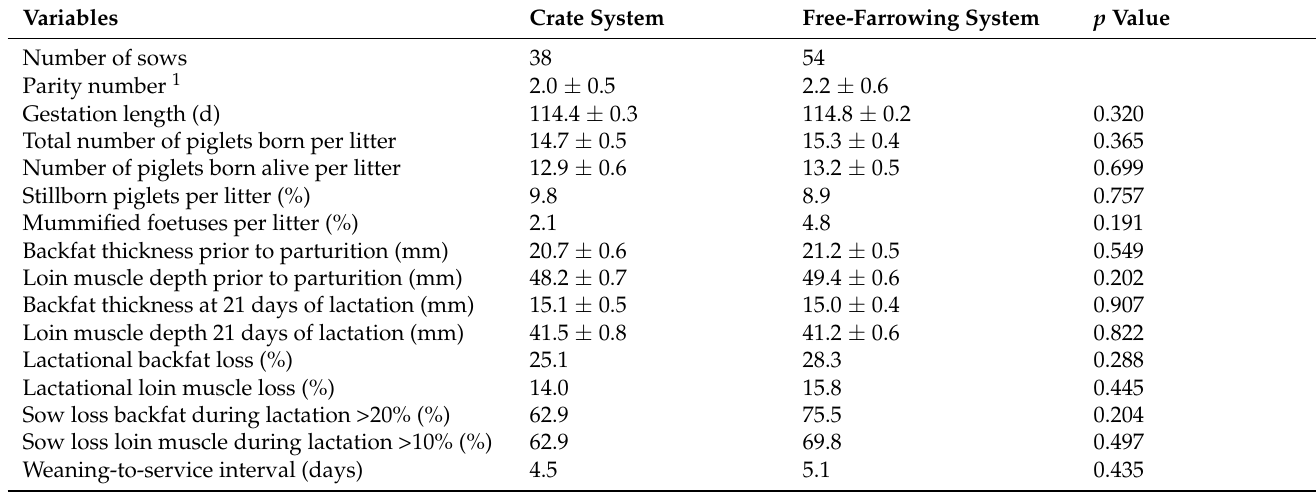
Table 1. Gestation length, litter traits and metabolic parameters in sows kept in the crate system compared to sows kept in the free-farrowing system in a tropical environment (Lsmeans ± SEM).